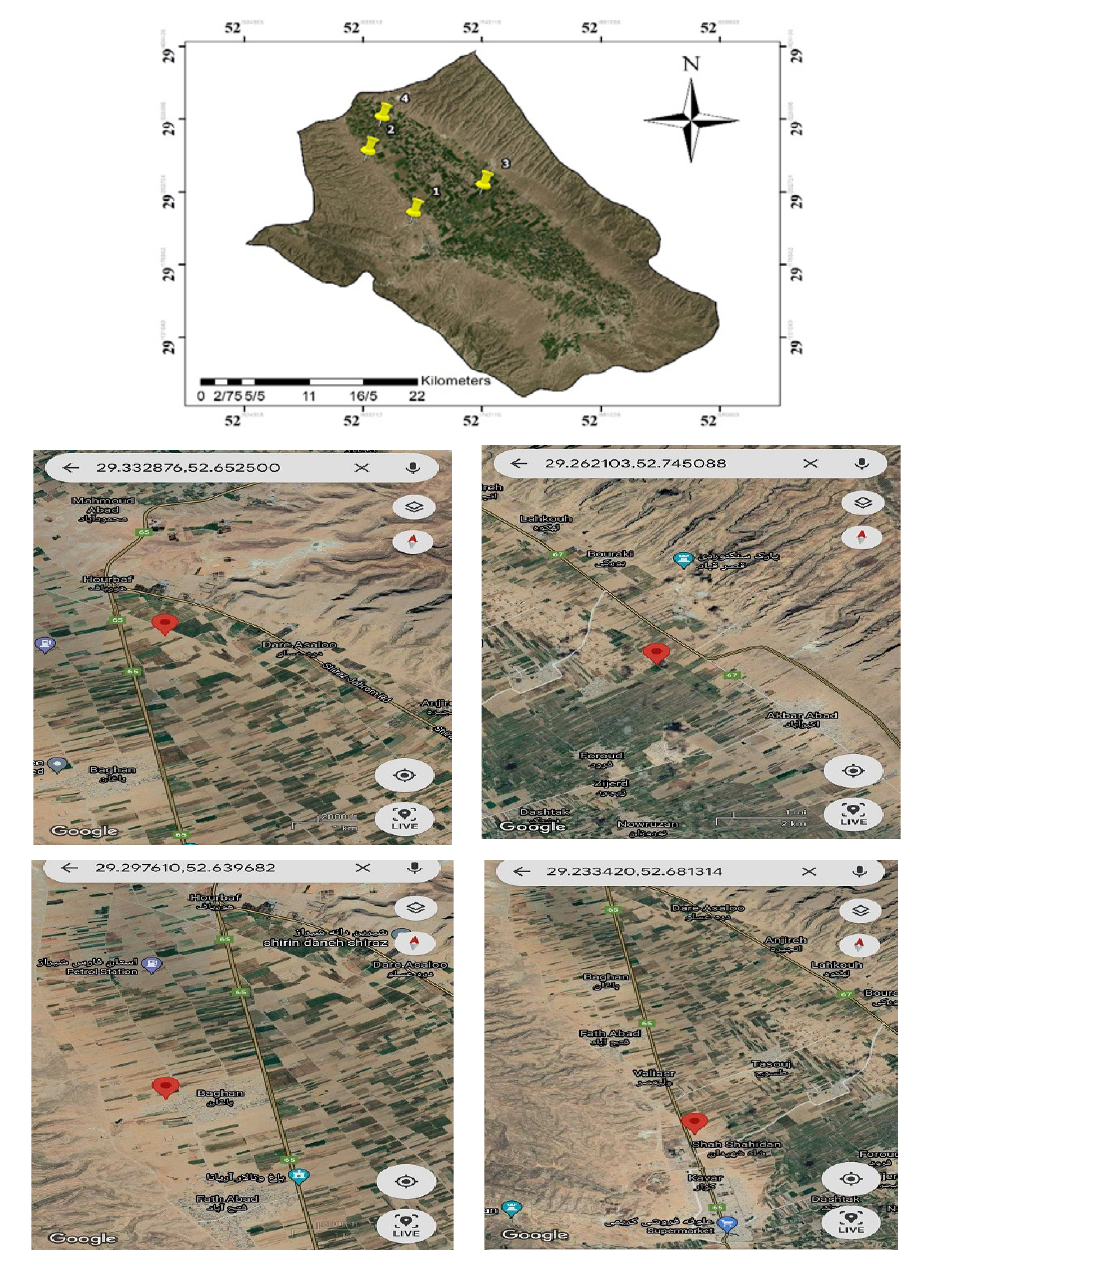
Figure 3. The location of selected recharge areas relative to the flood path in the Aquifer